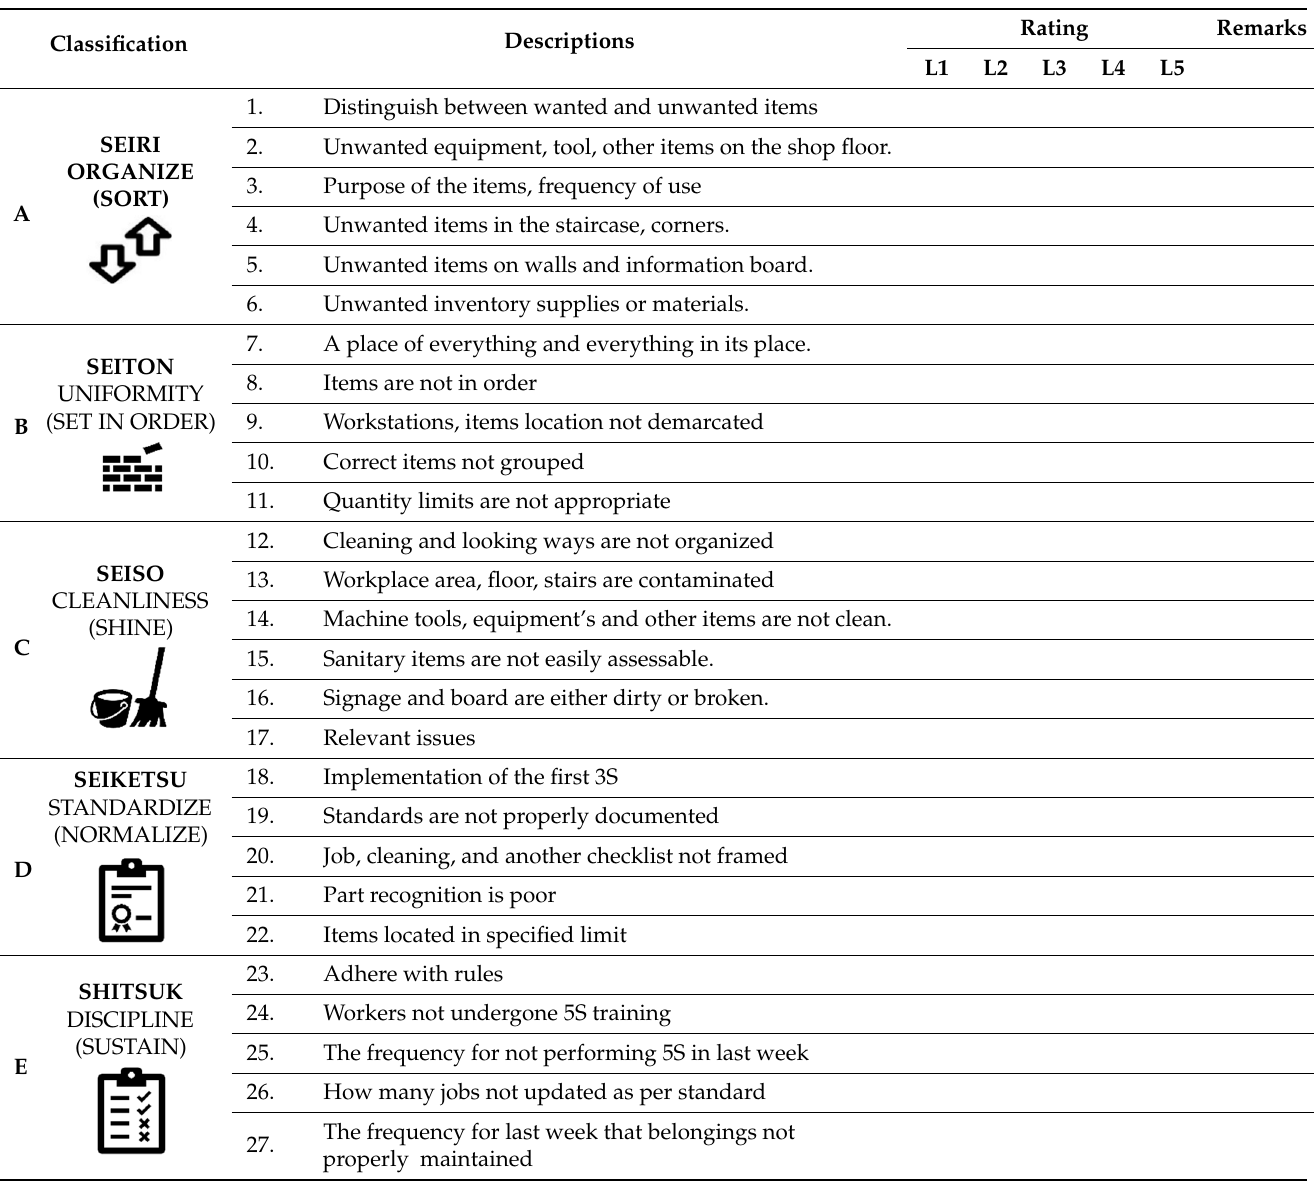
Table 3. Shop floor scan cum diagnostic sheet.